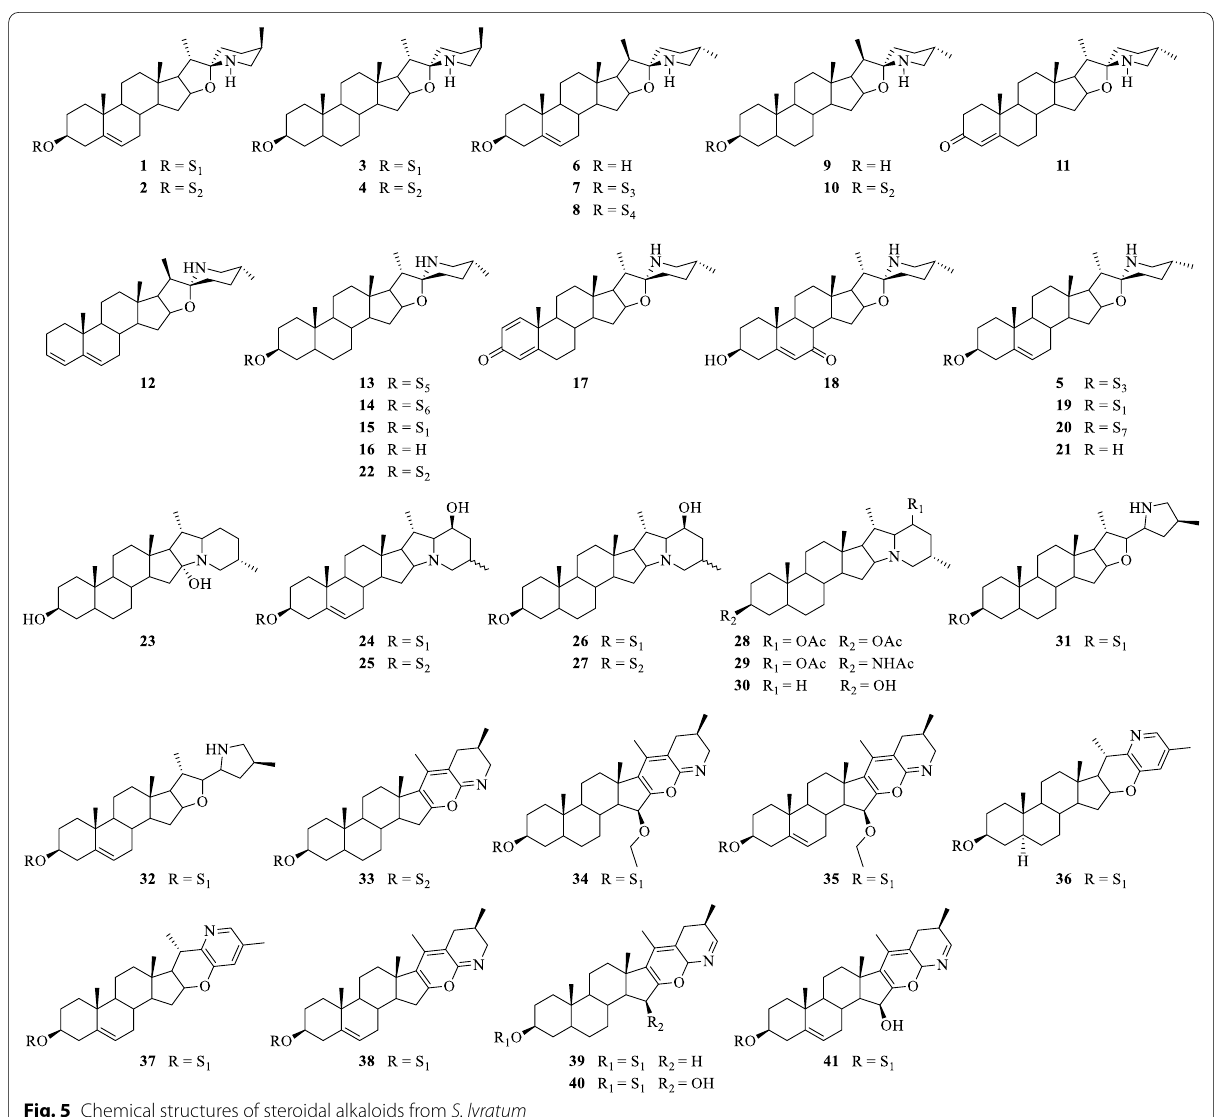
Fig. 5 Chemical structures of steroidal alkaloids from S.